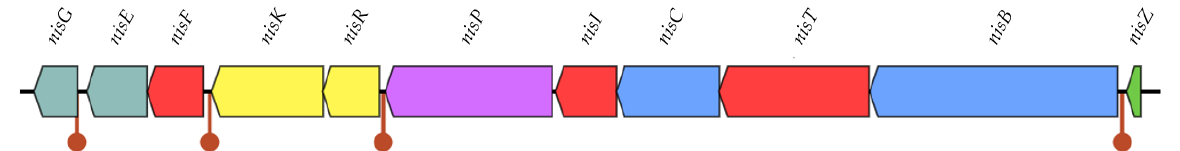
Figure 2. Prediction of the gene cluster encoding the production of NisZ in L. cremoris WA2-67 using the online webserver BAGEL v.4.0. (http://bagel4.molgenrug.nl/, accessed on 25 December 2021) [29]. Predicted terminators are shown as maroon line circle ends.